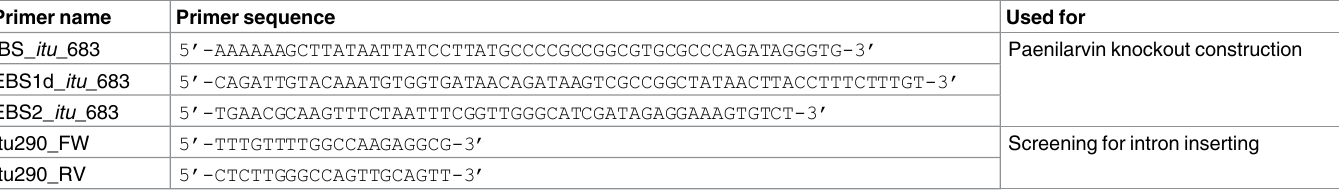
Table 2. Primers used for generating and verifying the paenilarvin gene cluster inactivation